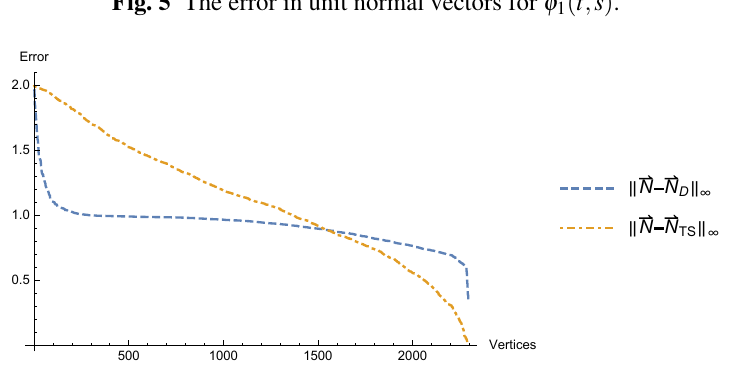
Fig. 5 The error in unit normal vectors for φ 1 ( t , s ) .